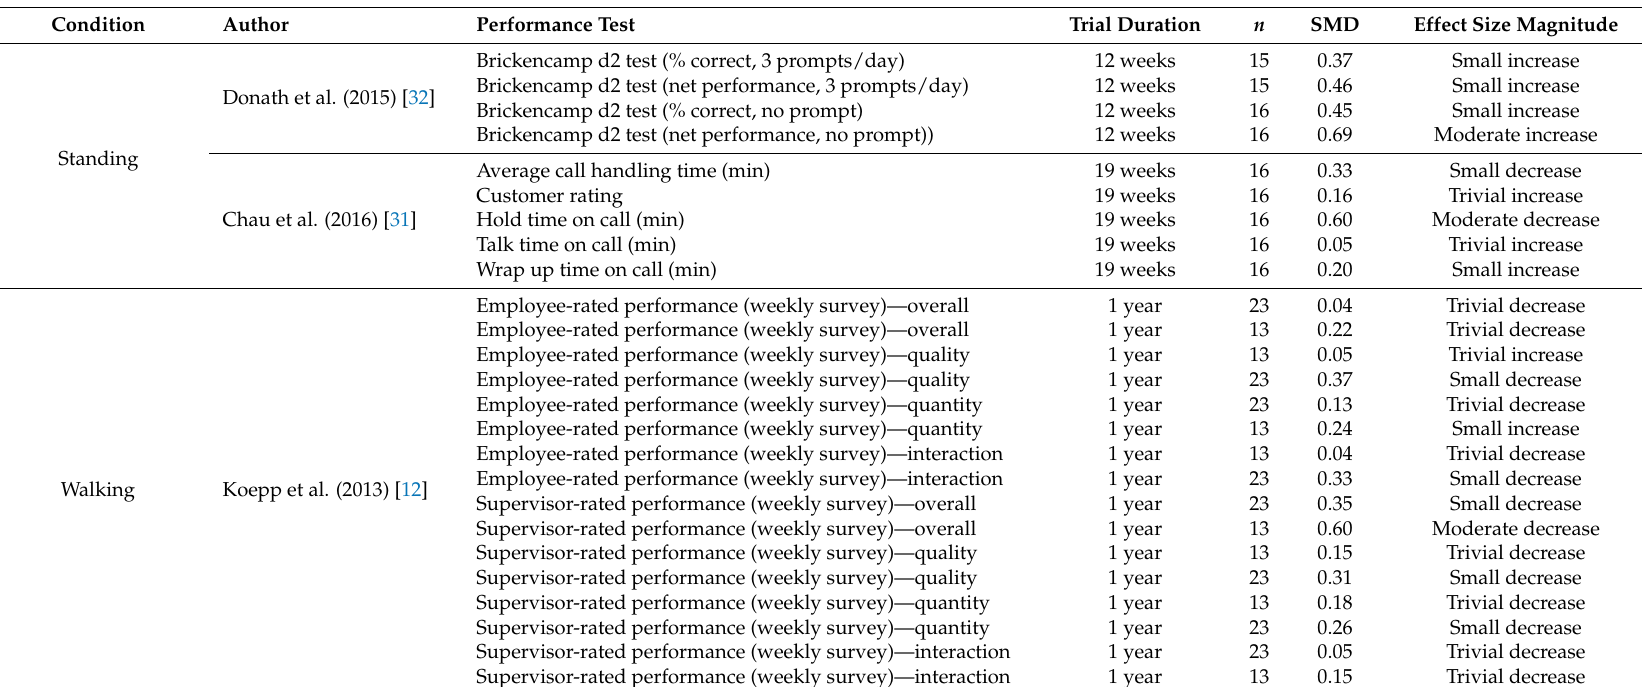
Table 7. Effect of active workstation use on work-related productivity